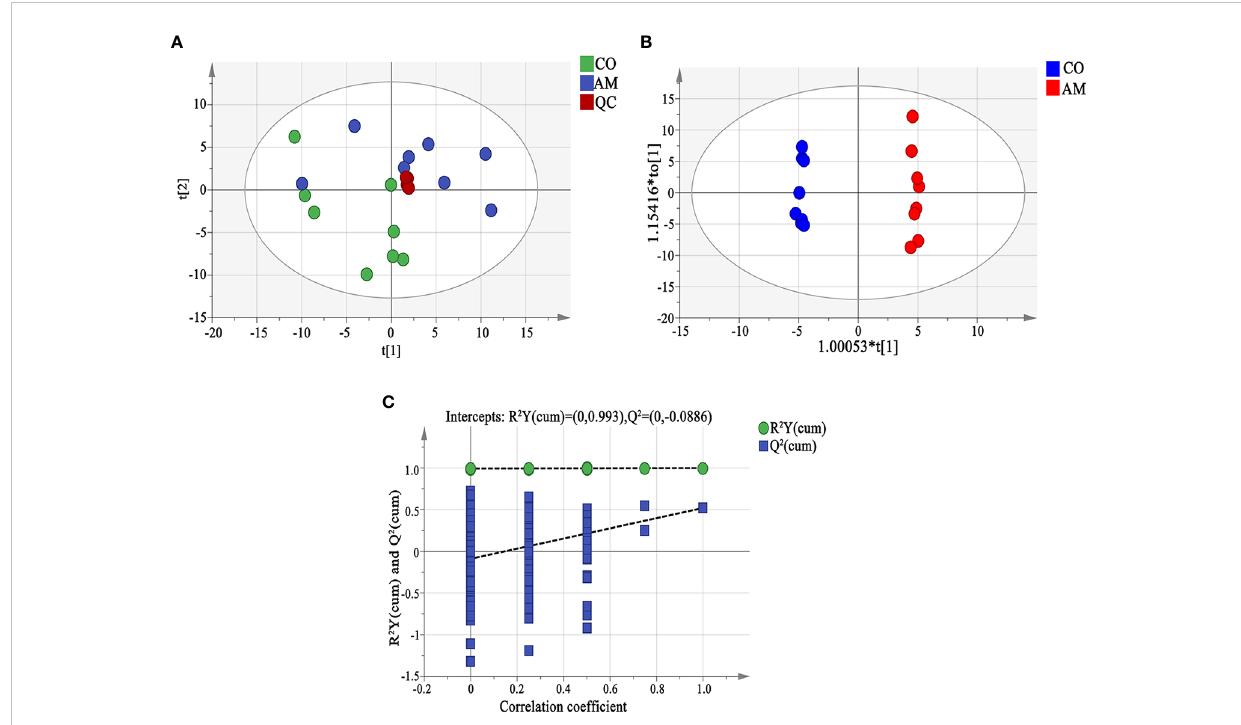
FIGURE 5 Fecal metabolomic analysis. (A) Principal component analysis (PCA). The distance of each coordinate point represented the degree of aggregation and dispersion between samples. A close distance indicated high similarity between the samples. PC1 and PC2 represented the contribution values of the fi rst and second principal components, respectively. (B) OPLS-DA analysis displayed the grouped discrimination of the control and AM groups by the fi rst two PCs. (C) OPLS-DA model validation. The abscissa representsed the replacement reservation degree of the replacement test. The ordinate represented the values of R 2 (green dot) and Q 2 (blue square), and the two dashed lines represented the regression lines of R 2 and Q 2 . QC, quality